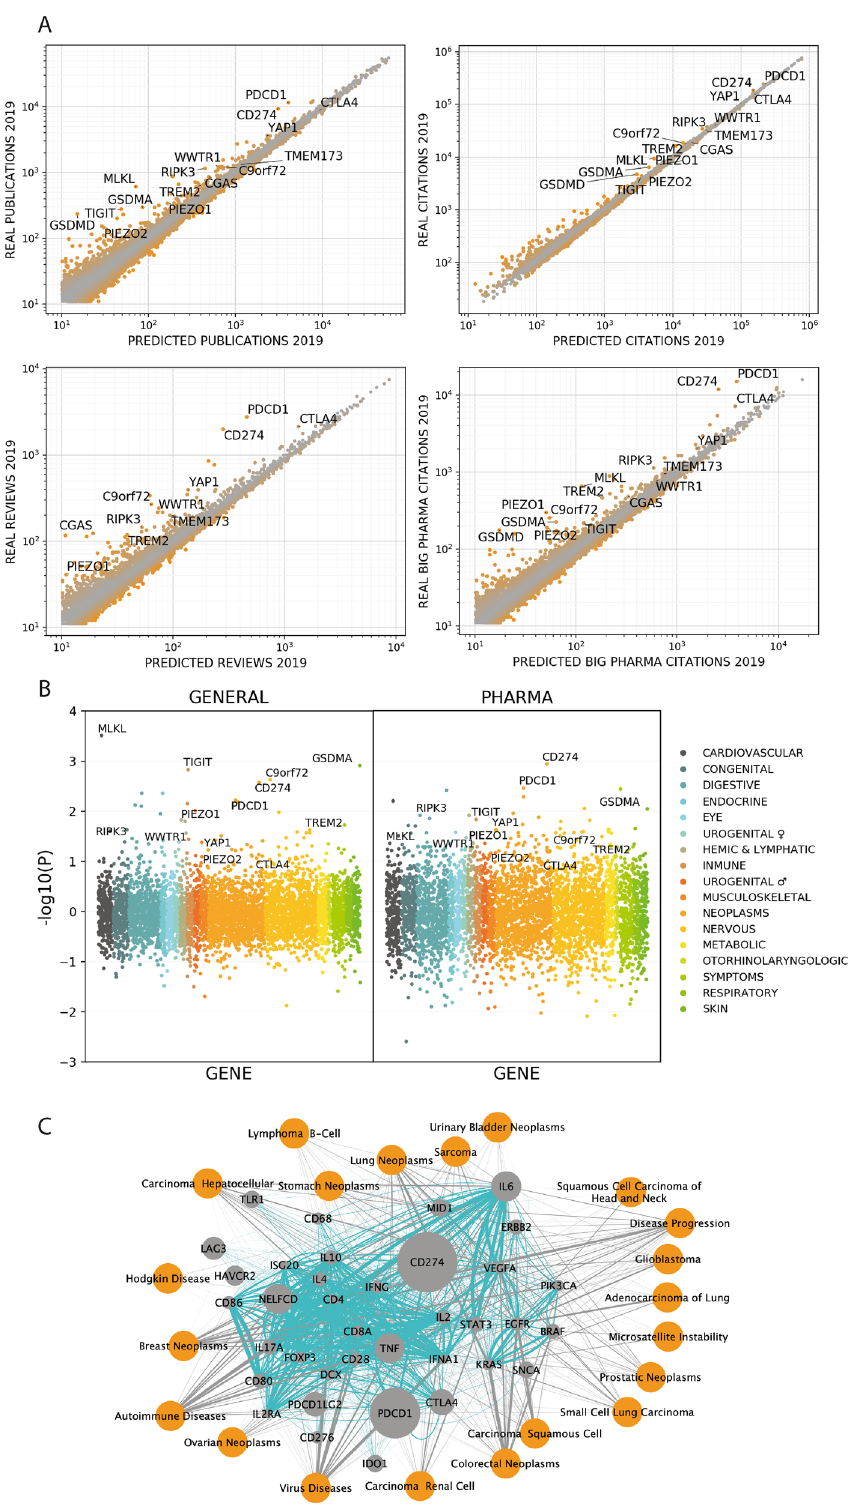
Figure 3. Trend detection and gene–gene-disease co-occurrence. (A) Logarithmic scatter plots showing the predicted number of publications, reviews, citations and citations from big pharma companies against real data in the year 2018. (B) Trendiness (log2(predicted/real)) for genes associated with groups of diseases (MeSH parent categories). Left; Average trendiness of publications, reviews, citations and citations from reviews. Right; Average trendiness of citations coming from big and medium sized pharmaceutical companies. (C) Gene– Gene–Disease co-occurrence network of the first neighbours of CD274. Orange nodes are diseases, grey nodes are genes and the size of gene nodes represents the trendiness The grey edges are gene-disease association, the blue edges are gene-diseases with the width of the edges reflecting the number of